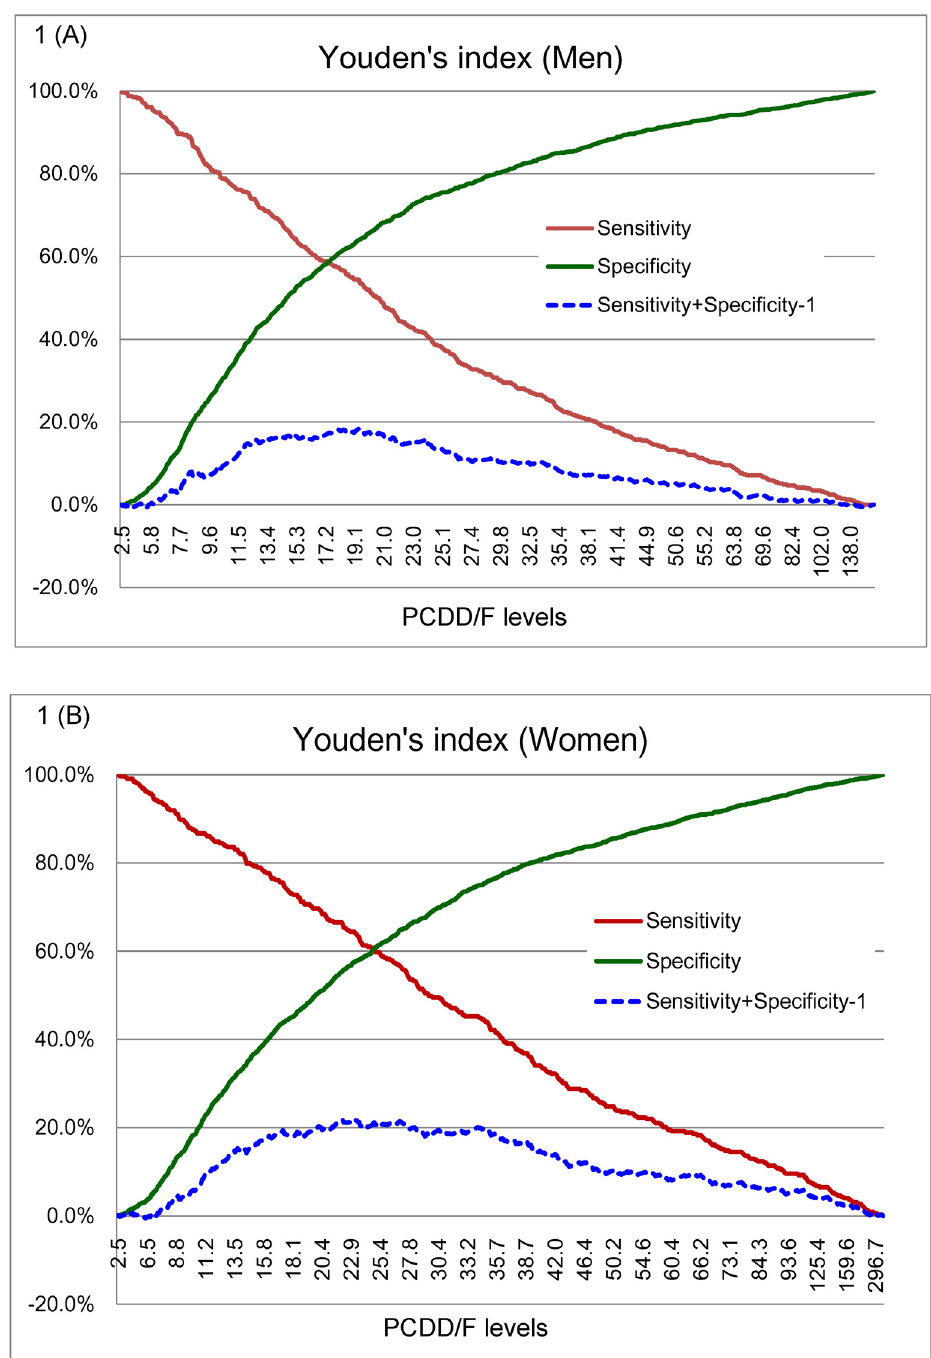
Fig 1. Two-graph receiver operator characteristic (ROC) curves for HOMA-IR against serum PCDD/F levels. These graphs indicate changes in sensitivity and specificity based on changes in the serum PCDD/F levels for (A) men and (B) women. Youden ’ s index (sensitivity + specificity − 1) is also shown. Abbreviations: HOMA-IR, homeostasis model assessment of insulin resistance.